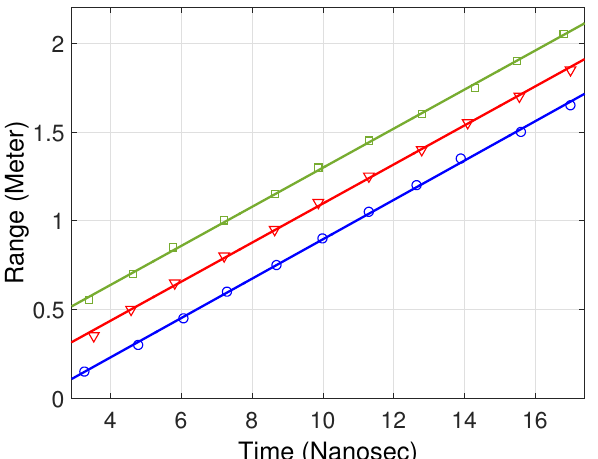
Figure 2. The pulse time-of-flight as a function of the range from the mirror, through seawater collected at different distances from shore and measured at the lab. Blue circles, red triangle and green squares represent data for seawater of 300, 1000 and 2400 m from shore, respectively. The mea- surements were displaced vertically by 0.2 m for presentation purpose only. The solid lines are linear fits to the data. The measured refractive indices are 1.35 ± 0.03, 1.365 ± 0.03, and 1.36 ± 0.03, respectively. All the values agree well, up to measurement error, with the measured values from previous works. Measurement errors are smaller than the symbol